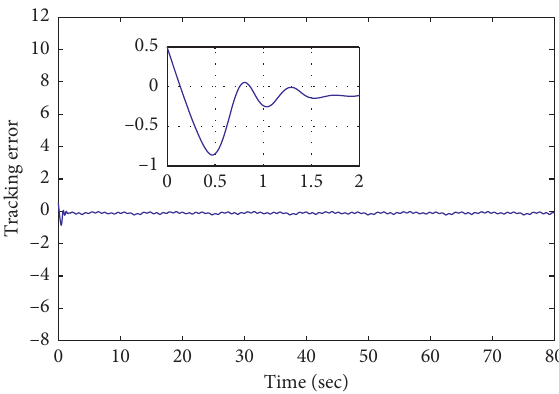
Figure 1: Tracking error q ( t ) − q